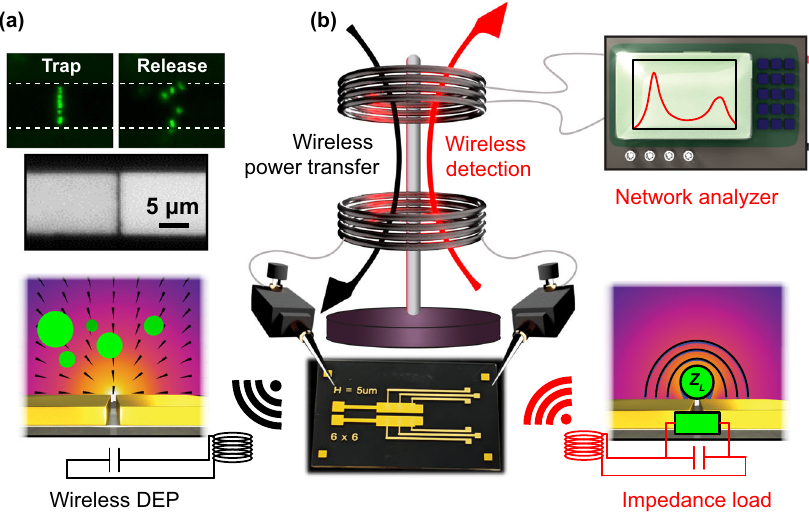
fi eld gradients create a polarization force that collects particles towards the nanogap(lowerleft, “ WirelessDEP ” ).Atthisjunction,thecon fi nedelectric fi eldsare sensitivetochangesinthedielectricload(lowerright, “ Impedanceload ” ),resulting in a discernable shift in re fl ected impedance, which is measured wirelessly across our nanogap array device (center) using a network analyzer (upper